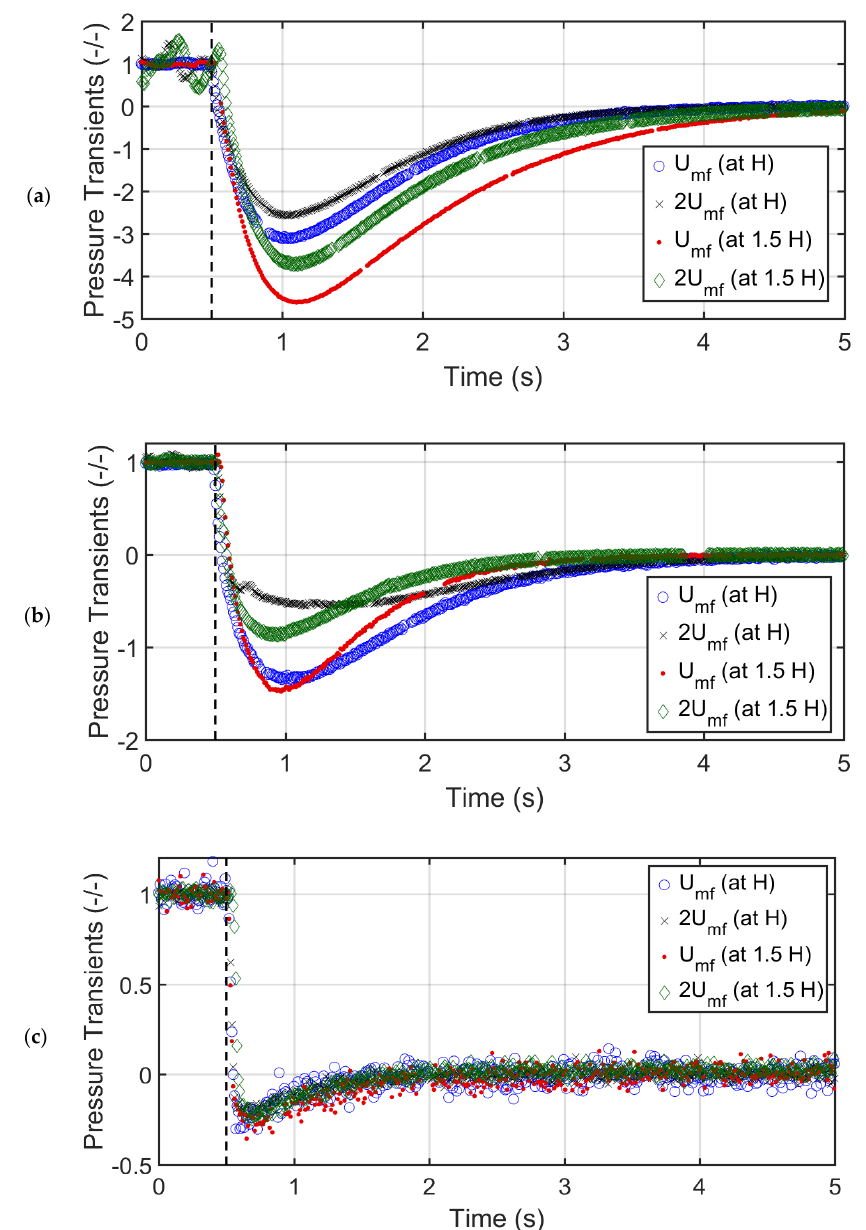
Figure 11. Distributor pressure drop of the bed at U mf and 2 U mf for ( a ) glass beads, ( b ) titania, ( c ) nanosilica. Figure 11 indicates that the bed voidage clearly affected the pressure drop minimum. The maximum negative pressure drop values attained by the glass beads, titania, and na- nosilica collapse beds were approximately − 4.7, − 1.5 and − 0.65, respectively. A low bed voidage leads to a higher specific surface area of the solid phase in the bed, resulting in